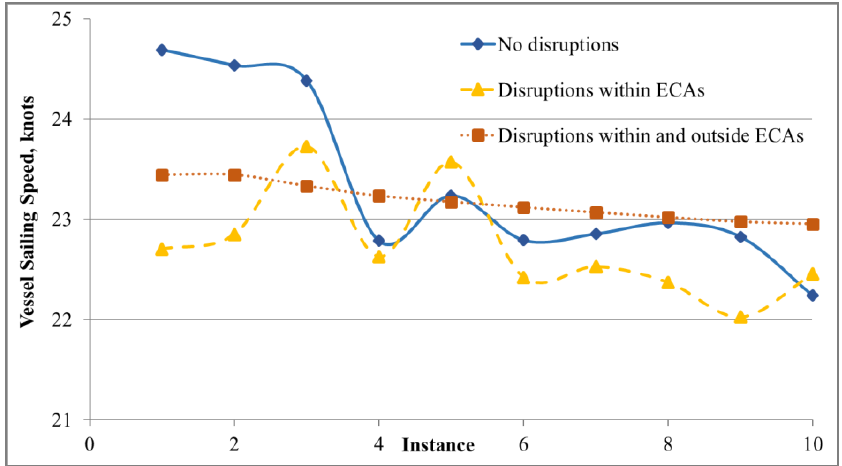
Figure 8. The average vessel sailing speed for the considered problem instances.